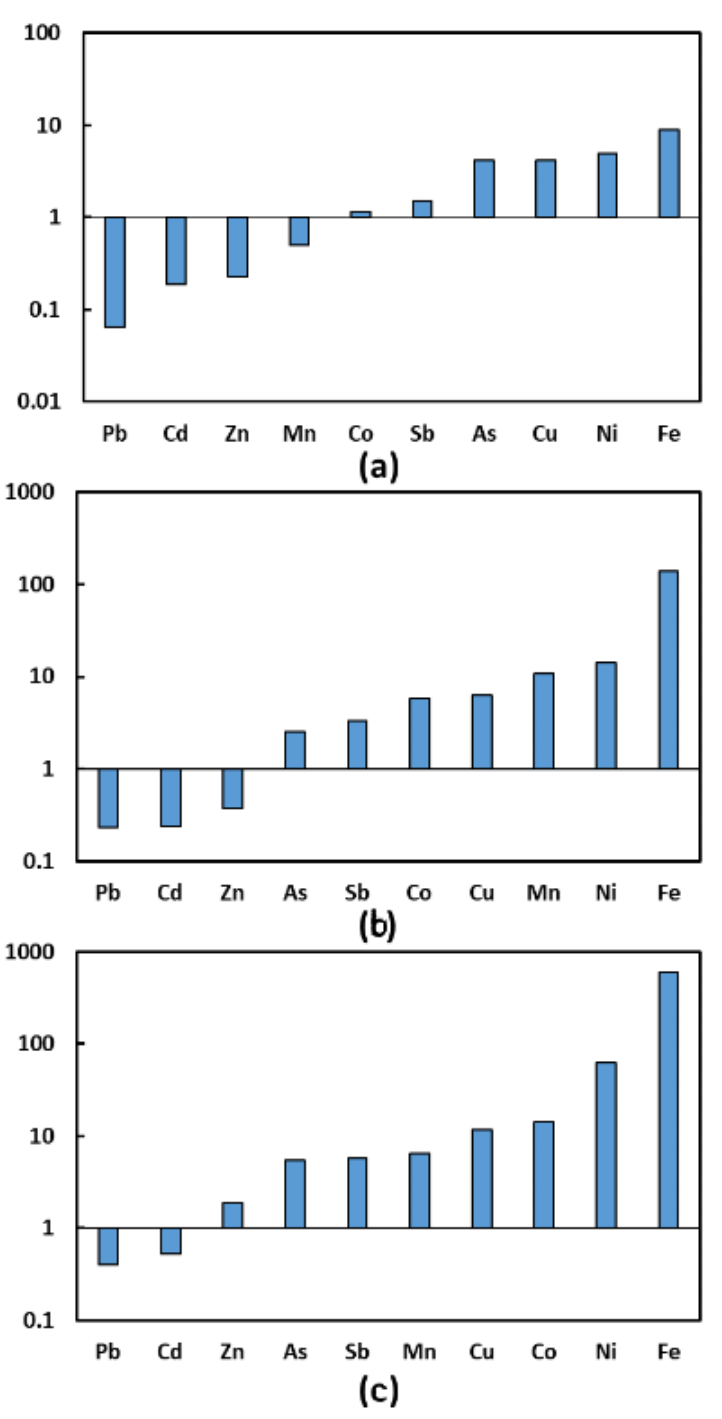
Figure 6. The ratio of mean dissolved flux of rivers in three latitudinal zones (53–60 ( a ), 60–62 ( b ), and 62–66° N ( c )) of the WSL to the stock of dissolved fraction of snow. For this calculation, the snow volume (in millimeters of water) accumulated over full winter and mean river runoff during May and June were used.